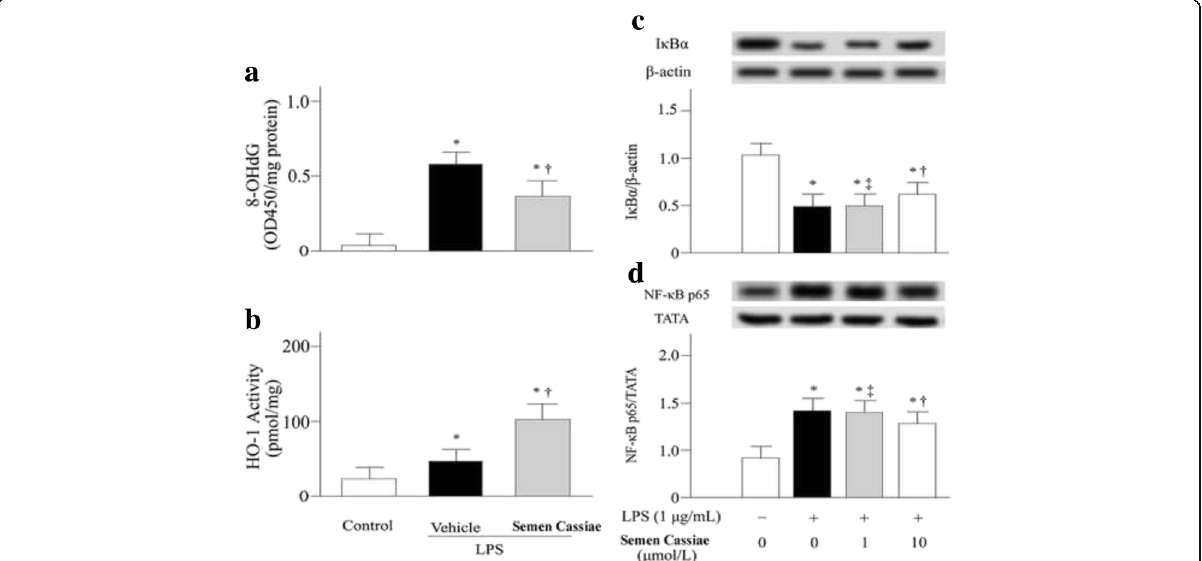
Fig. 3 Alterations of 8-hydroxy-2 ′ -deoxyguanosine (8-OHdG) ( a ), and heme oxygenase (HO)-1 activity ( b ) in control or lipopolysaccharide (LPS) challenged rats treated with vehicle or Semen Cassiae . Alterations of I κ B α levels in cytoplasm ( c ), and Nuclear factor (NF)- κ B p65 levels in nuclear ( d ) in RAW264.7 cells in control or lipopolysaccharide (LPS) challenged group pretreated with vehicle or Semen Cassiae . Data are expressed as the mean ± SEM and compared by one-way analysis of variance and the Student-Newman-Keuls method. * P < 0.05 when compared with control group; † P < 0.05 when compared with LPS + Vehicle group. ‡ P > 0.05 when compared with LPS + Vehicle